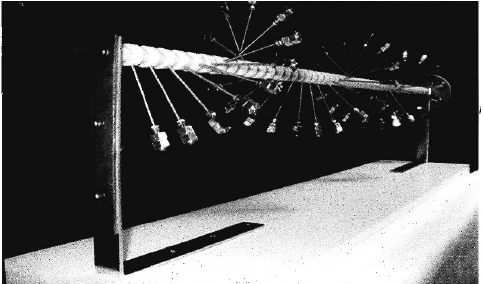
Figure 10. Chain of pendulums as a mechanical analogue of the Frenkel–Kontorova model.